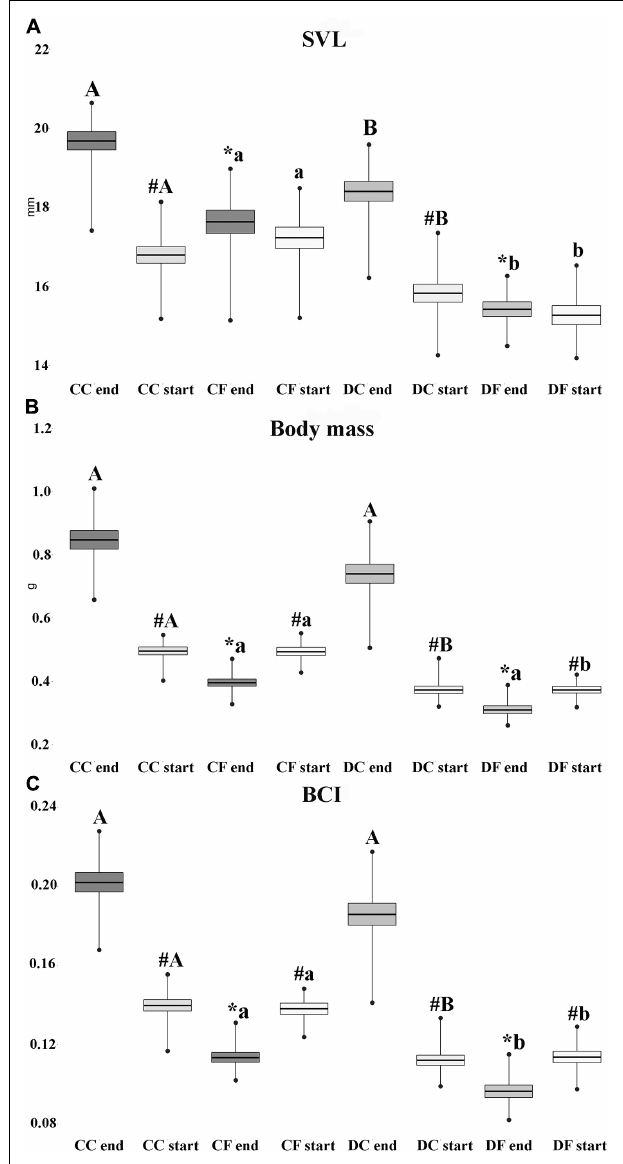
FIGURE 1 | Biometric parameters: snout-vent length [ (A) – SVL in mm], body mass [ (B) – BM in g] and body condition index [ (C) – BCI] at the start and end of the fasting/feeding treatment for individual that developed under conditions of desiccation and constant water. CC, feeding individuals that developed under constant water availability; CF, fasting individuals that developed under constant water availability; DC, feeding individuals that developed under exposure to the desiccation regime; DF, fasting individuals that developed under the desiccation regime. SVL and BM are given as mean ± standard error of raw data, BCI on log-transformed data. “#” indicates significant differences between same groups at the end and start of treatment; “*” indicates significant differences between fasting and feeding treatments under the same water regime; capital letters “A” and “B” indicate differences between feeding individuals exposed to desiccation and constant water availability (start vs. start, and end vs. end); lower case letters “a” and “b” indicate differences between fasting individuals exposed to desiccation and constant water (start vs. start, and end vs. end). Different letters indicate significant differences ( P ≤ 0.05). Line, Mean value; box, Standard error; bars, Minimal and maximal